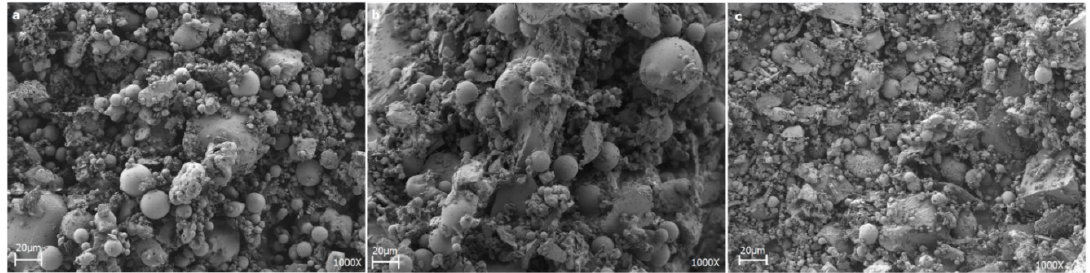
Figure 7. Scanning electron microscopy images: ( a ) Mixture 1, ( b ) Mixture 2, and ( c ) Mixture 3 prior to thermal treatments.